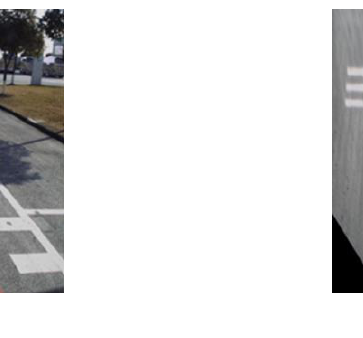
Figure 3. Images in front view and bird’s-eye view: ( a ) Front-view image; ( b ) Bird’s-eye-view image.